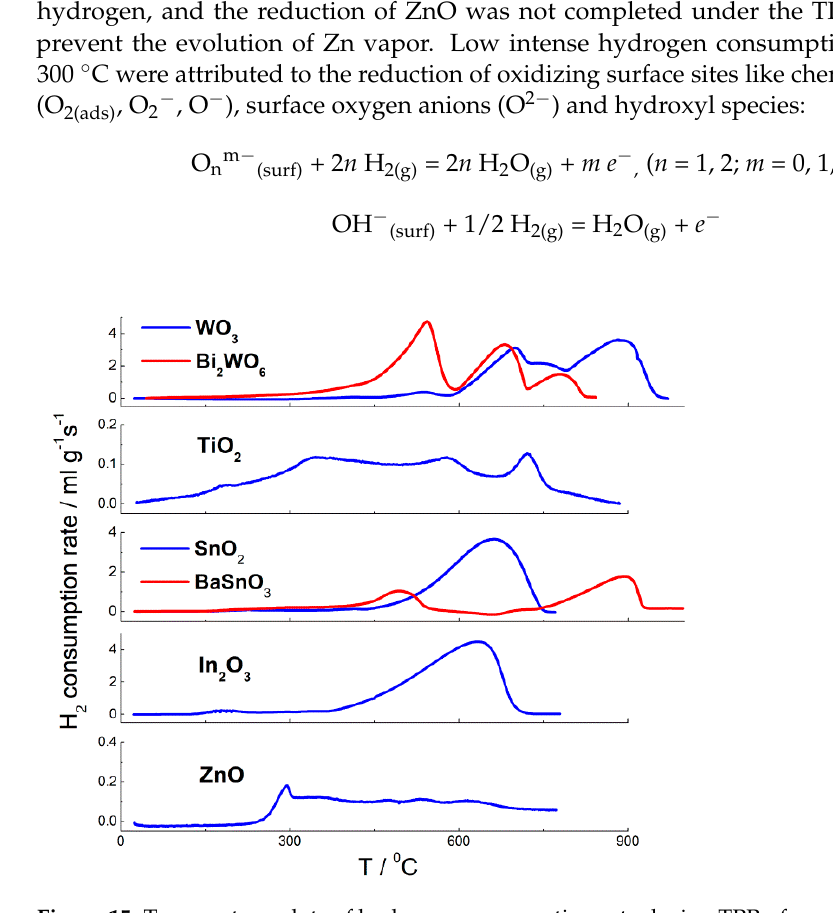
Figure 15. Temperature plots of hydrogen consumption rate during TPR of nanocrystalline n -type MOS. Adapted with permissions from ref. [63] copyright 2021 Elsevier; ref. [75] copyright 2018 Elsevier; ref. [76] copyright by the authors (CC BY); ref. [78] copyright 2021 Elsevier; ref. [79] copy- right 2014 American Chemical Society.